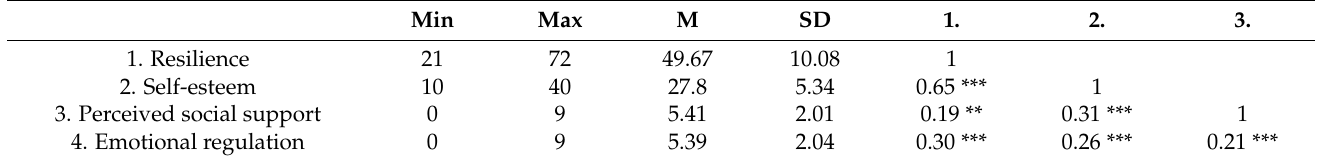
Table 1. Mean and correlations of test results (N = 251).